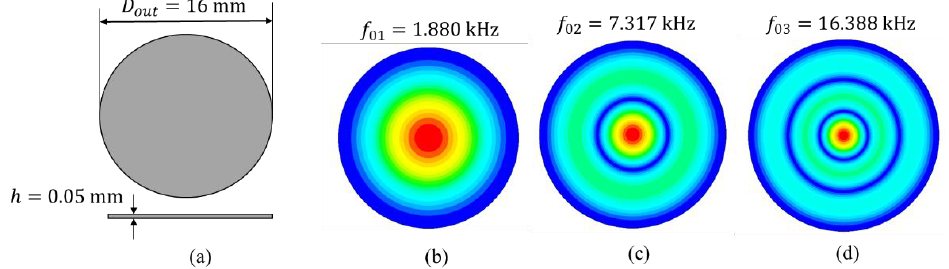
Figure 4. ( a ) Geometry used for the FEM modal analysis. ( b – d ) Contour plots of the first three axisymmetric vibrational modes estimated for the homogeneous thin plate.